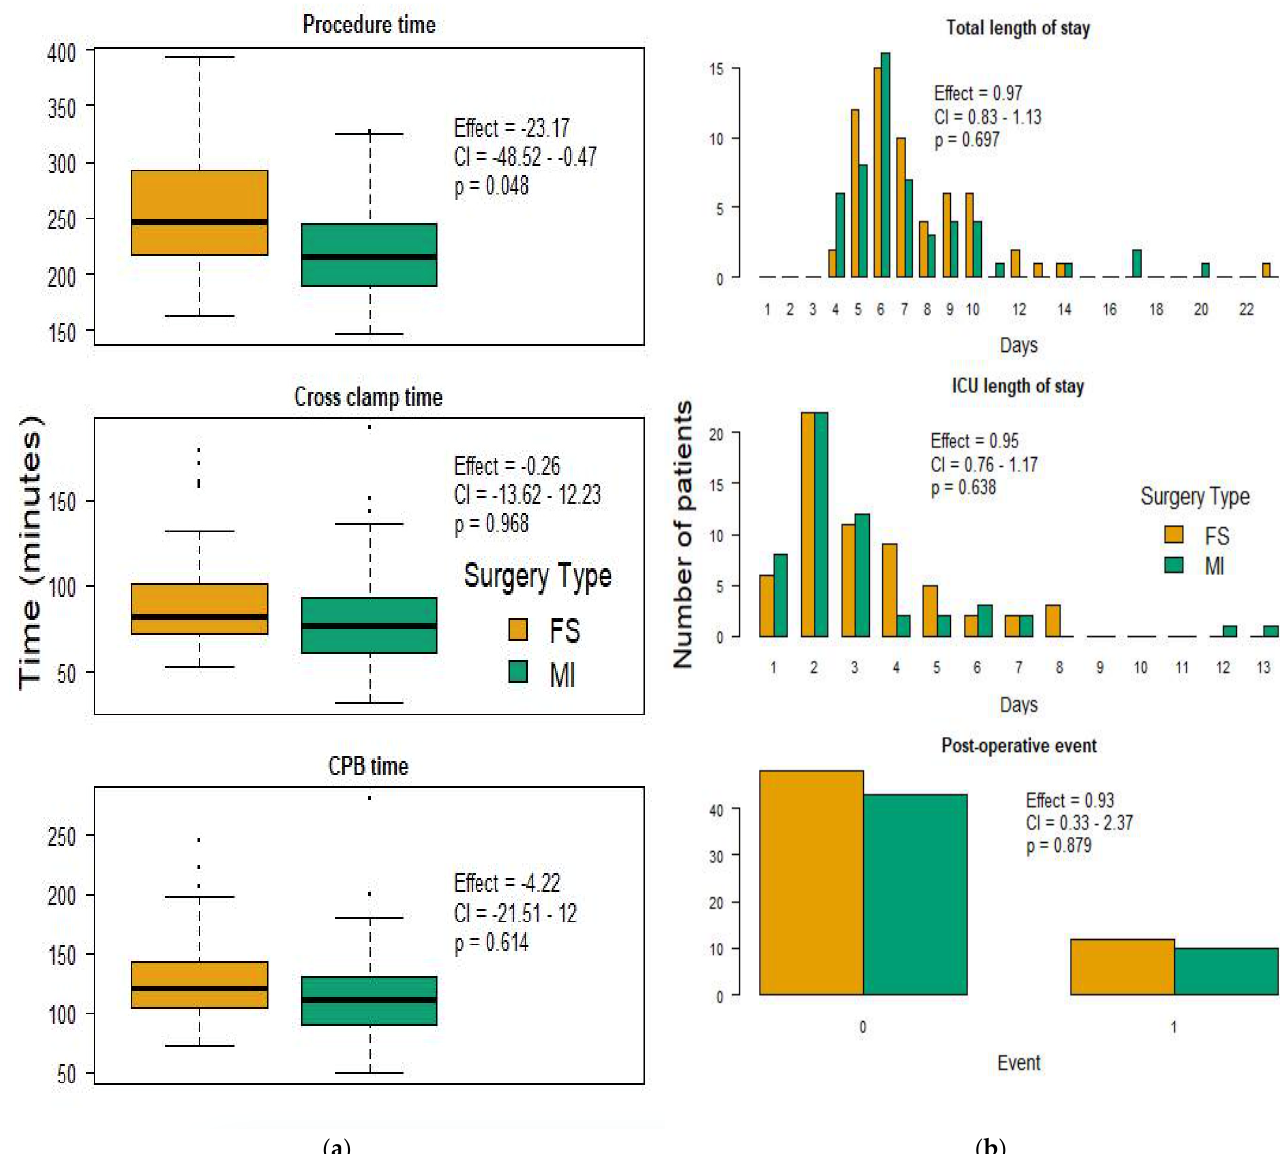
Figure 1. Perioperative time intervals and select postoperative outcomes. ( a ) Mean procedure, cross-clamp, and cardiopulmonary bypass (CPB) times in minutes comparing minimally invasive (MI; green) and full sternotomy (FS; yellow). ( b ) Comparison of patient postoperative intensive care unit (ICU) and total hospital length of stay in days and postoperative events, with 0 indicating no events and 1 representing adverse event occurrence. Table 2. Perioperative parameters and postoperative outcomes.